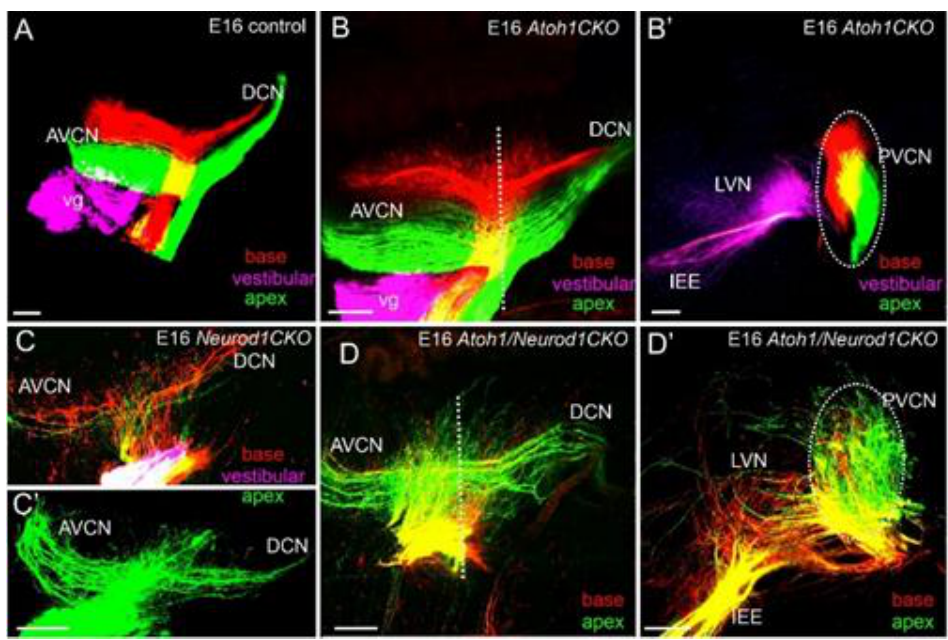
Figure 6. Cochlear neurons show different innervation patterns in various mutations. Central projections to the anterior (AVCN) and dorsal (DCN) cochlear nucleus are nearly identical between controls ( A ) and Atoh1 CKO mice ( B , B’ ). In contrast, both Neurod1 CKO ( C , C’ ) and Atoh1/Neurod1 CKO mice ( D , D’ ) show aberrant central projections. Note the difference is obvious in control sections ( B’ ) compared to Atoh1/Neurod1 CKO mice ( D’ ). Bar 100 µm. Modified after [43].